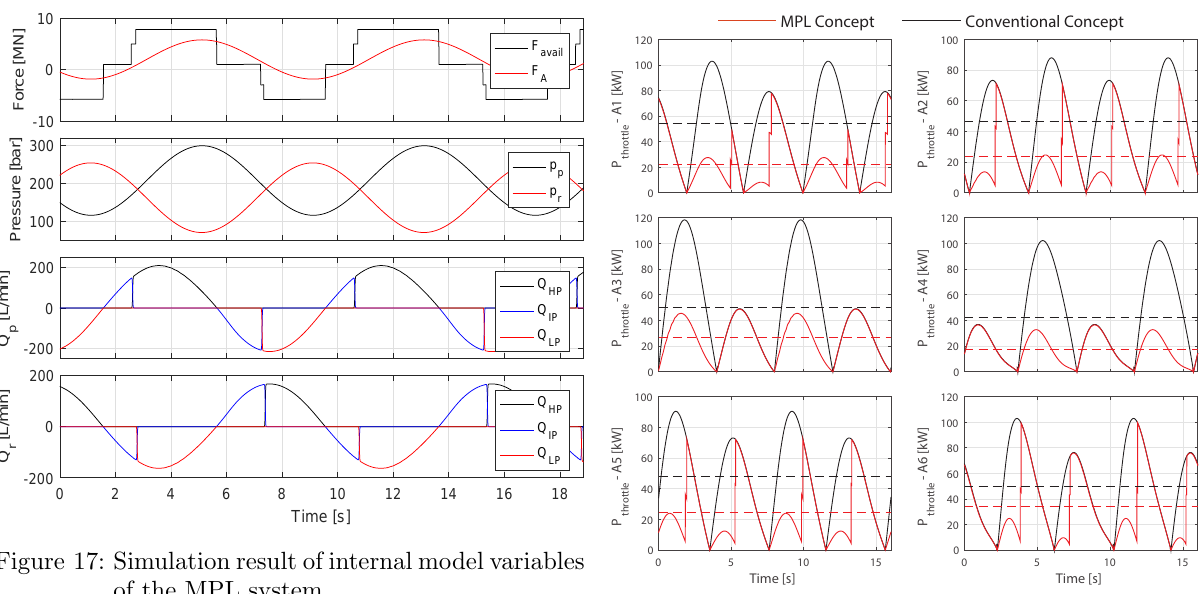
Figure 18: Throttled power comparison between MPL concept using online pressure